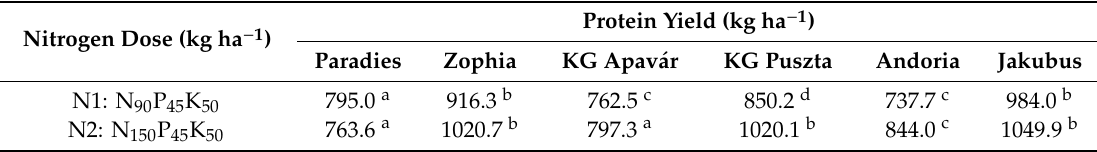
Table 6. Protein yield of winter barley cultivars (2020, Debrecen). Nitrogen Dose (kg ha − 1